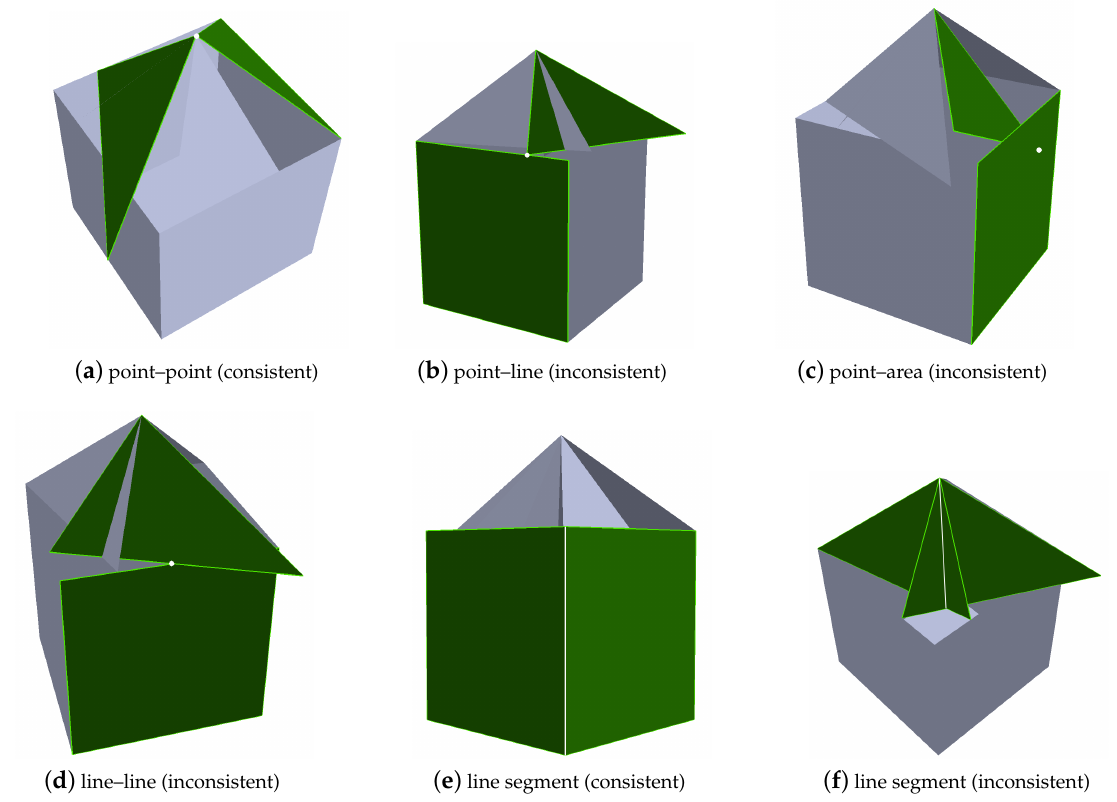
Figure 4. Simple synthetic example of a house with different kinds of topological inconsistencies. The green geometries depict the different types of intersection